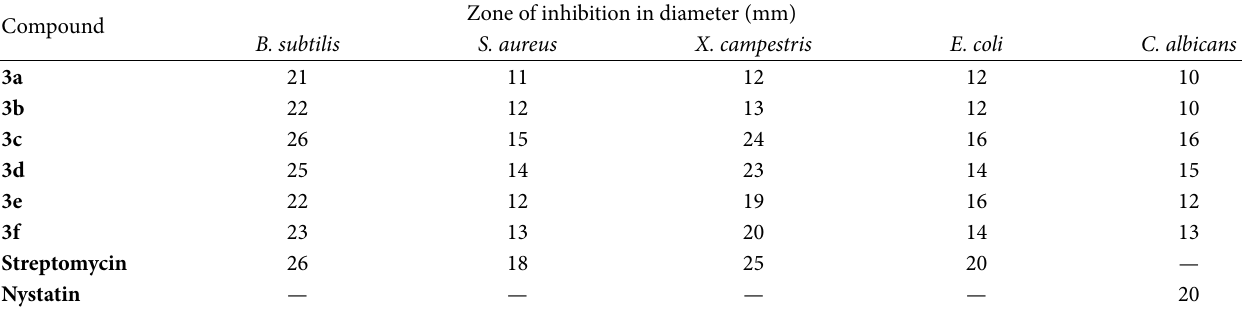
T 2: In Vitro antibacterial and antifungal activities of compounds